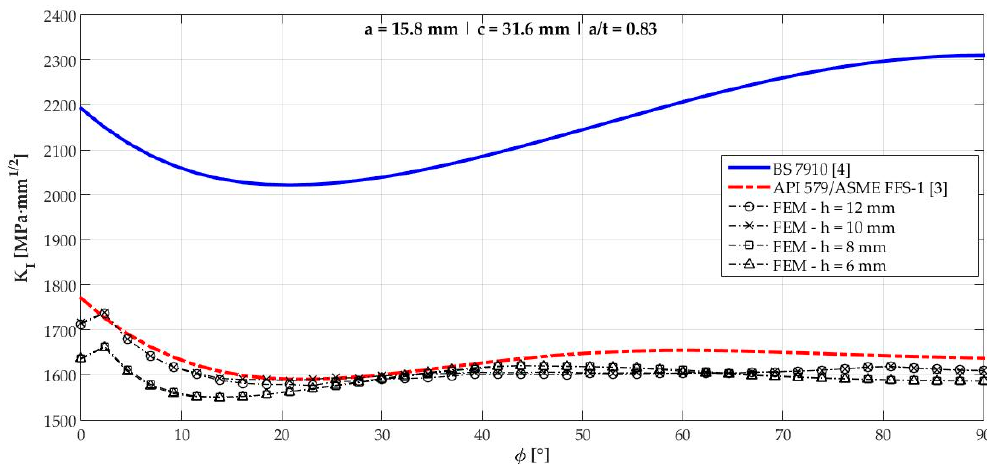
Figure 11. Mode I SIF profiles for crack 6 ( a = 15.8 mm , c = 31.6 mm , and a/t = 0.83 ).